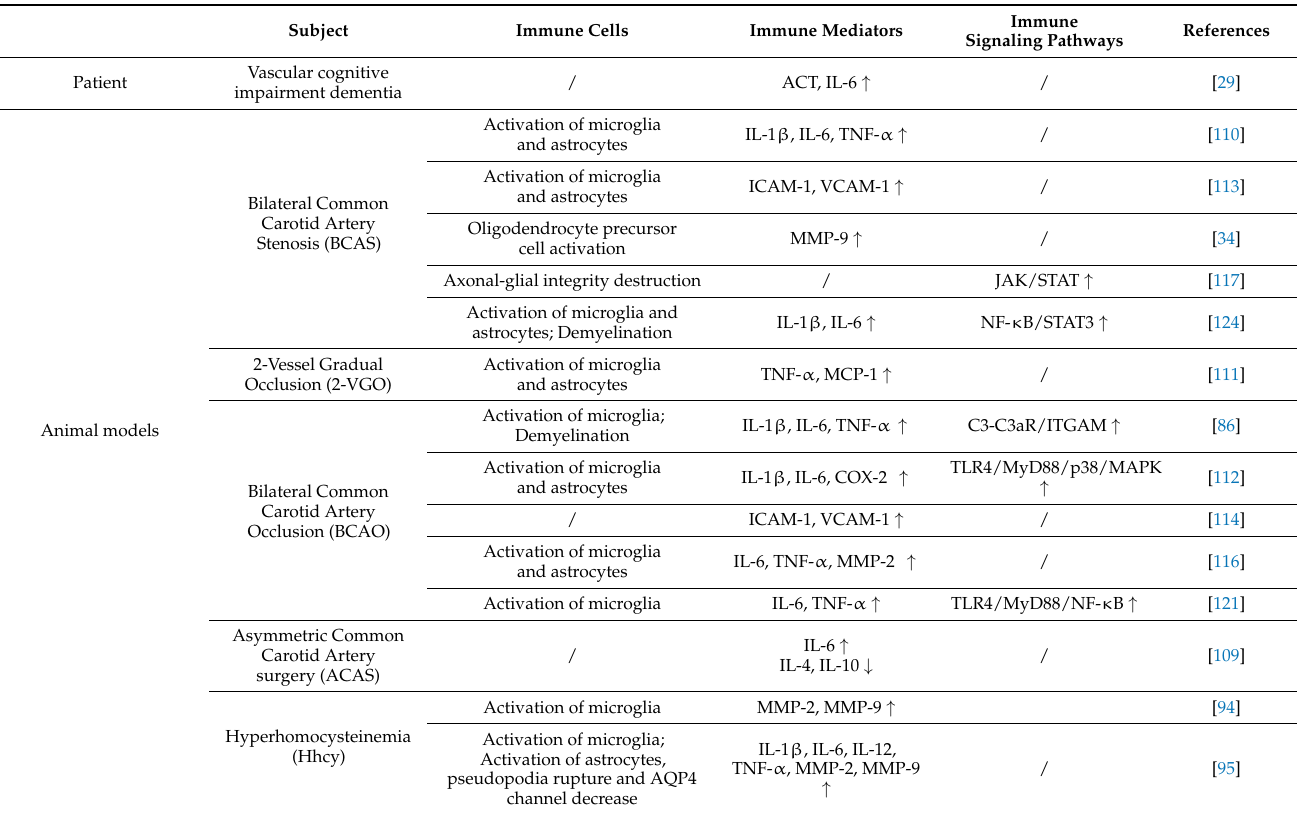
Table 1. Research progress on neuroinflammation in VCID patients and VCID animal